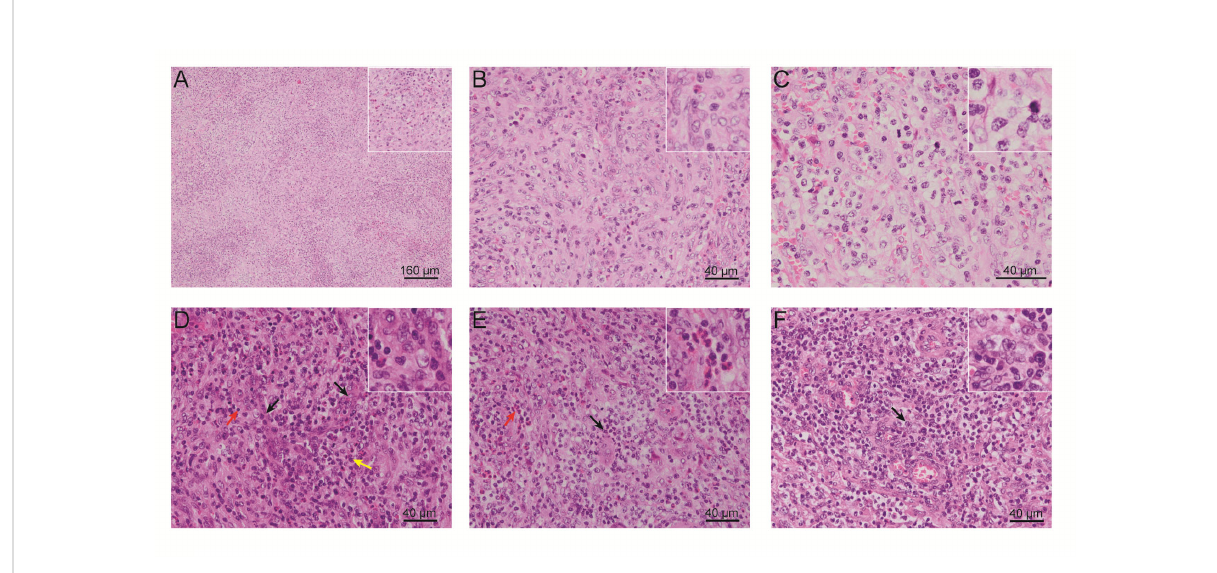
FIGURE 2 Representative H&E-stained images of the patient ’ s right inguinal lymph node. (A) Cell hyperplasia and perinodal in fi ltration. (B) Vortex distribution of spindle cells. (C) Medium-sized lymphoid tumor cells with mild atypia, unclear cell boundary, and abundant pale cytoplasm. Abundant branching of high endothelial small vessels, mixed with (D) small lymphocytes and plasma cells, (E) eosinophils and neutrophils, and (F) few scattered large immunoblastic cells. (H&E, Eosin &